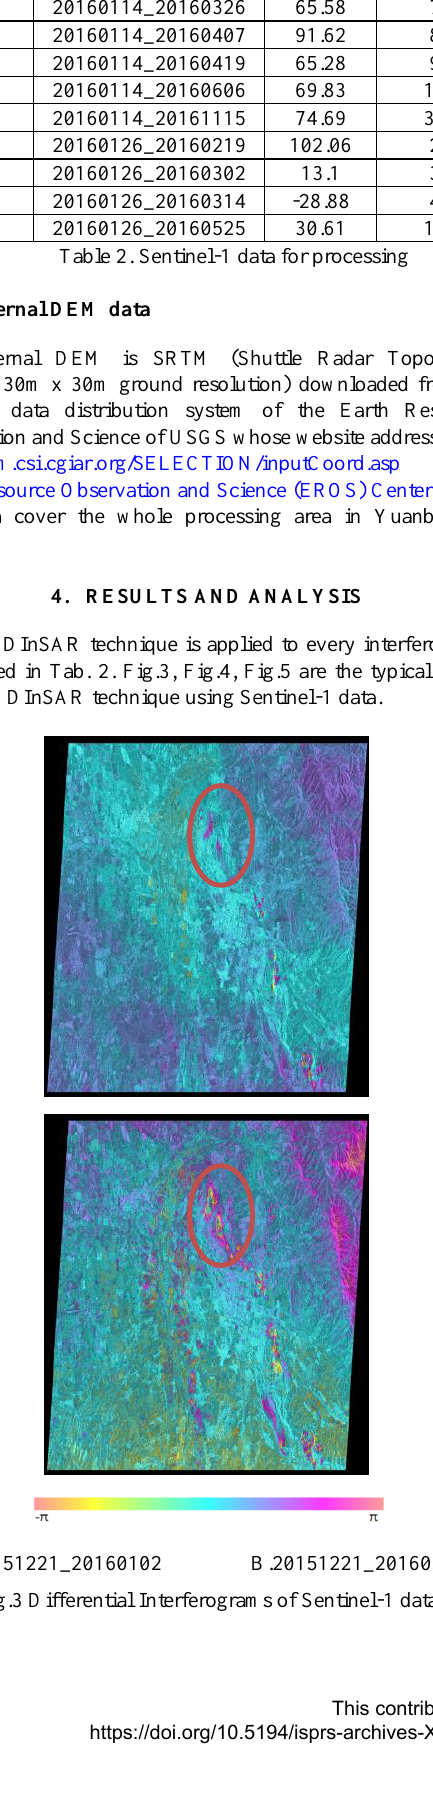
Because of long time baseline and vegetation growth, some parts of the results are suffered from low coherence. We select two interferometric pairs on Fig.3A as an example to analysis. Fig.3A appears a half-cycle interferometric fringe in 12 days around the key mining area. Each interferometric cycle represents that the deformation is half of a wavelength. Because Sentinel-1 data is C-band whose wavelength is 56mm, the largest deformation is approximately 14mm in Fig.3A. Fig.3B is the interferogram which has a common master image with fig.3A and the slave image whose imaging time is about three months later than that in fig.3A. The interferometric circle with more than 2 cycles appears around the key mining area, indicating that the maximum deformation is more than 56mm. Table 2. Sentinel-1 data for processing